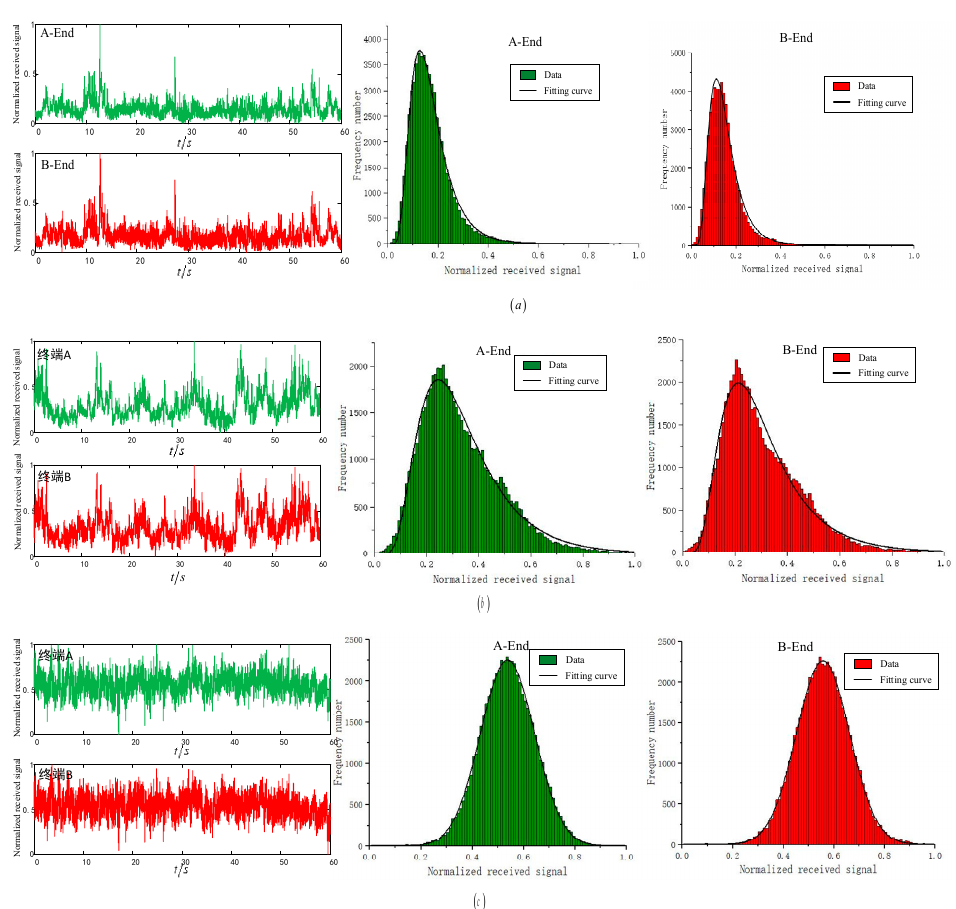
Figure 8. Data and probability density distribution of the receiving terminal spot measurement of the bidirectional transceiving coaxial atmospheric laser propagation link ( a ) γ AB = 0.8739, α A = 0.33895, α B = 0.33659; ( b ) γ AB = 0.9062, α A = 0.13269, α B = 0.13378; ( c ) γ AB = 0.9592, α A = 0.01125, α B =